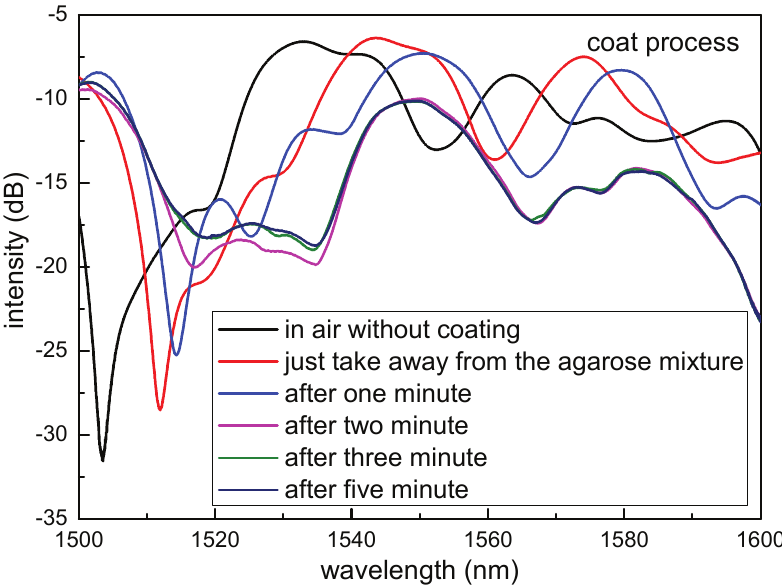
Figure 5. Transmission spectra of the sensor coated in one time by 0.1 wt/vol % agarose solution when the agarose gel film (AGF) is dehydration with time goes on.